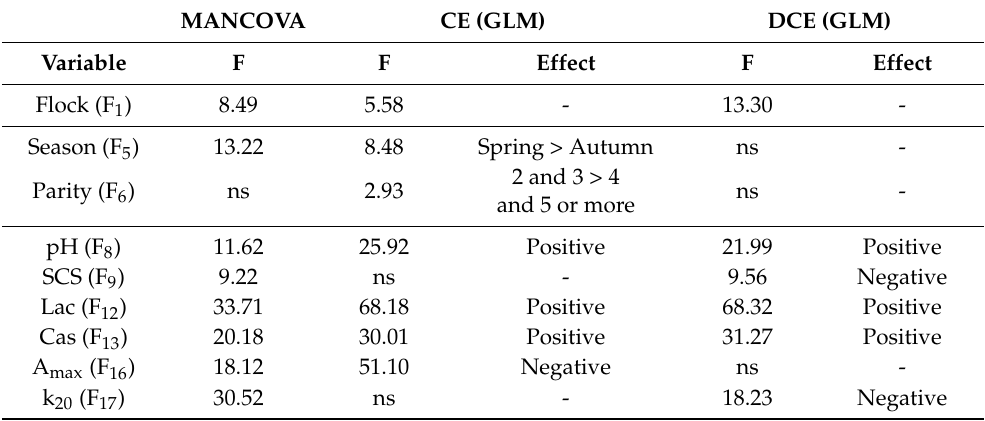
Table 7. Summary of the determinants for curd efficiency (CE and DCE) according to MANCOVA and GLM ( n =